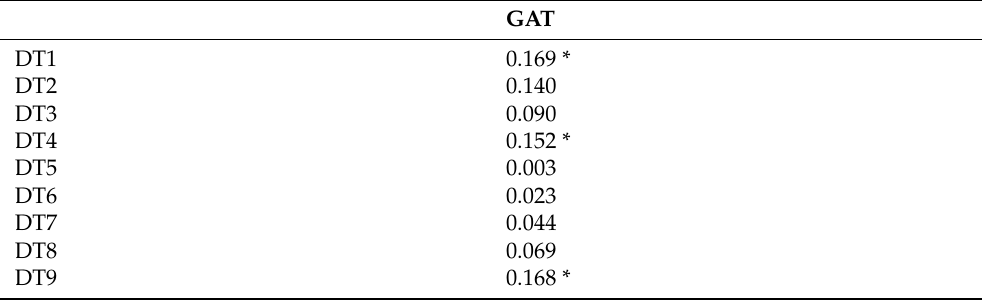
Table 5. Correlation between digital technologies and gross annual turnover